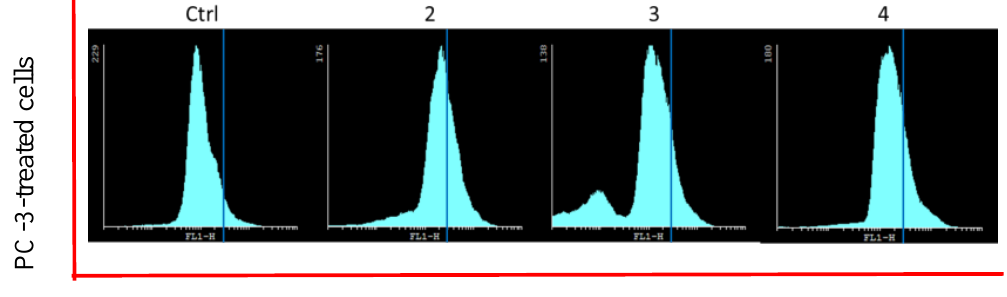
Figure 4. Effect of compounds 2 – 4 on caspases activity in PC-3 cell line was analyzed by flow cytometry. Cells were treated with compounds (25 µ M), posteriorly stained with CaspACE™ FITC-VAD-FMK and then analyzed by flow cytometry. Representative histogram showing changes on caspases activity.